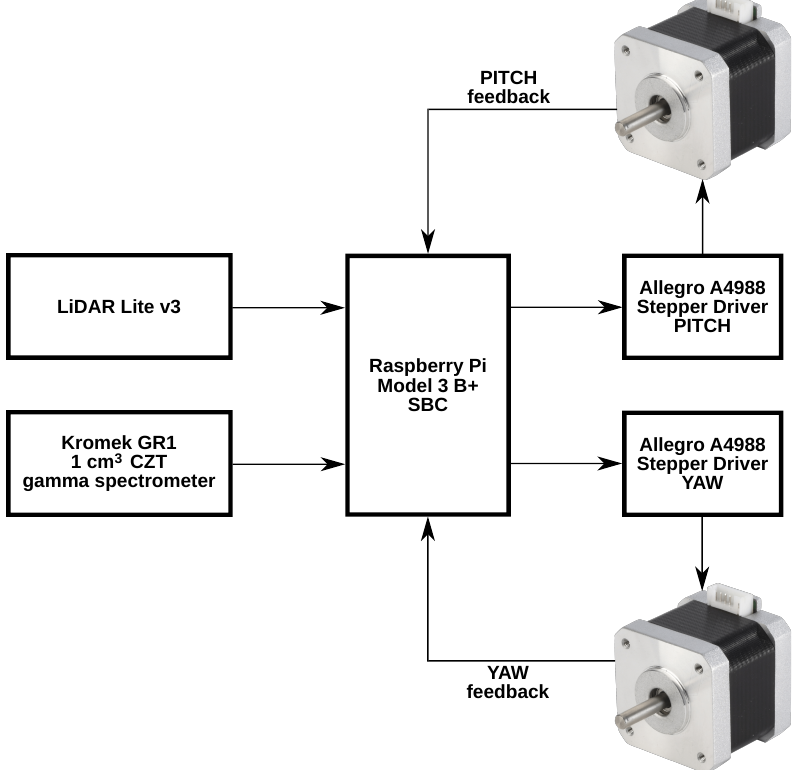
Figure 3. Block diagram of the CC-RIAS